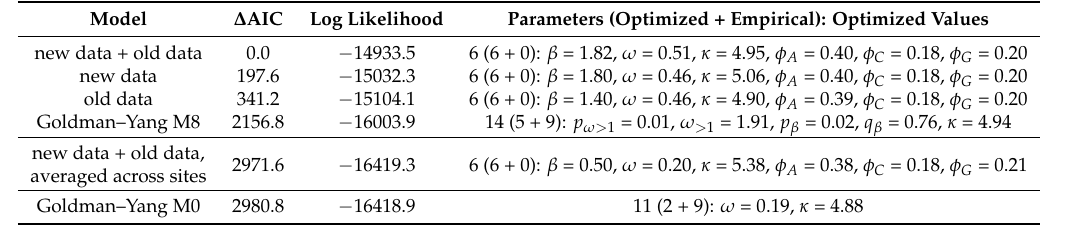
Table 1. The site-specific amino-acid preferences measured in the new experiments offer an improved description of HA evolution in nature. Aikake information criterion (AIC) [26] was used compare the maximum likelihood phylogenetic fit of several models to an alignment of seasonal human H1N1 and classical swine H1N1 HAs. The experimentally informed substitution models are of the form described in [24] with the data from the average of all three replicates of the new or old experiments, or the average of the two. These models are compared to the variants of the substitution model of Goldman et al. [27] denoted as M0 and M8 in Yang et al. [28] with the equilibrium codon frequencies estimated empirically using the F3X4 method. The best model is the one that combines all experimental data, but a model informed by the new experiments alone is better than one informed by the old experiments alone. To confirm that the experimentally informed models are superior because they are site specific, we fit a control model in which the experimental data is averaged across sites. The tree topology was fixed to that inferred by maximum likelihood using the M0 version of the Goldman–Yang model. The free parameters for each model were then optimized along with the branch lengths; optimized parameters are in the last